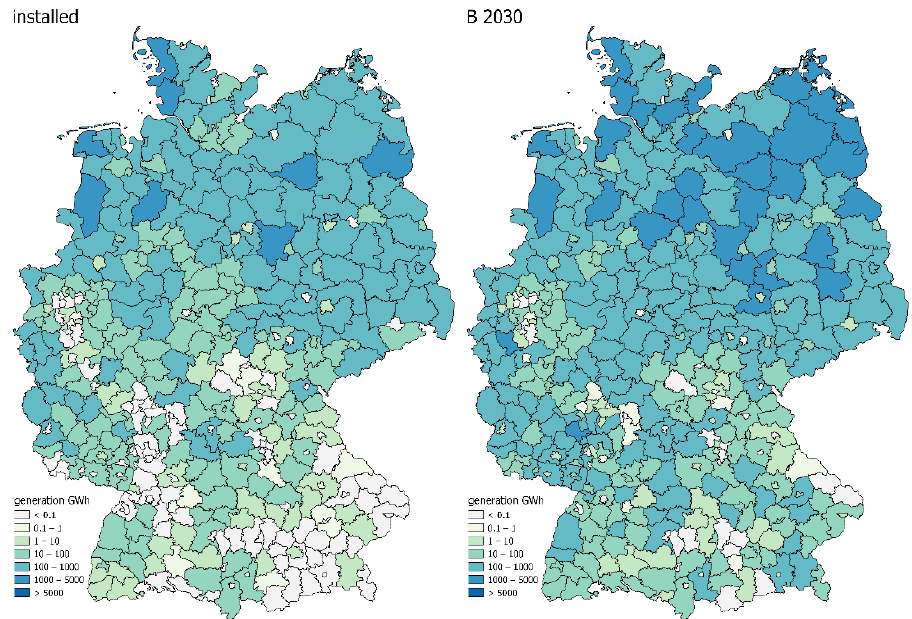
Figure 1. Comparison of annual wind electricity production in German districts in 2012 ( left ) and in the economic distribution scenario ( right ) [44].